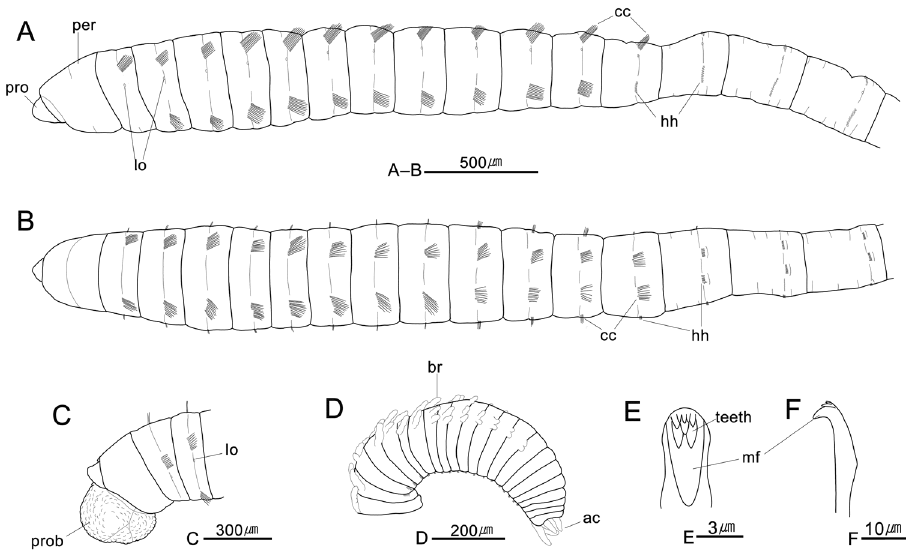
Figure 2. Leiochrides yokjidoensis sp. n. A anterior end, left lateral view B same, dorsal view C anterior end with proboscis (MABIKNA00145754), left lateral view D posterior end (MABIKNA00145754), left lateral view E–F hooded hooks from anterior abdominal notopodium. Abbreviations: ac, anal cirri; br, branchia; cc, capillary chaeta; hh, hooded hook; lo, lateral organ; mf, main fang; per, peristomium; pro, prostomium; prob,